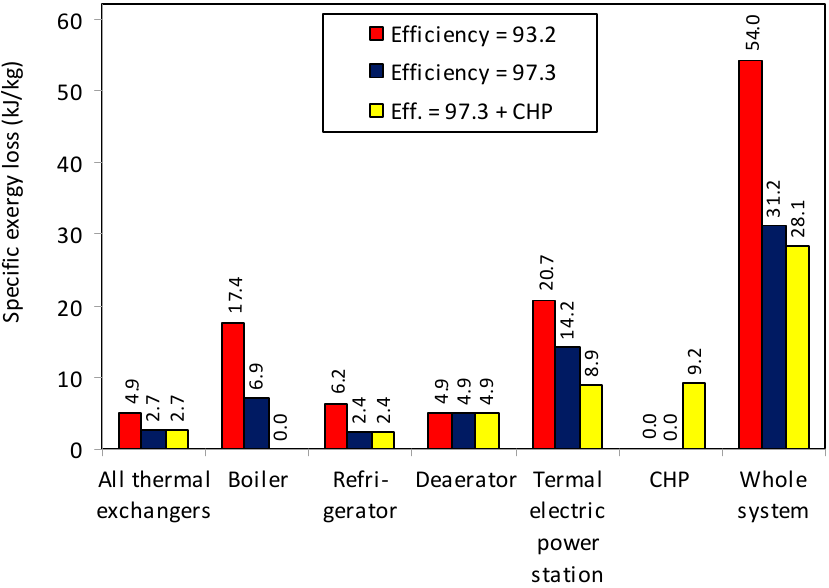
Figure 4. Exergetic losses (kJ kg − 1 milk ) in the all thermal exchangers and in the additional elements of the pasteurization systems (deaeretor, refrigerator, thermal electric power station, boiler) for the three e ffi ciencies: current ε A = 93.4%; optimized ε opt = 97.3%; optimized ε opt = 97.3% plus a cogeneration heat and power (CHP) system.